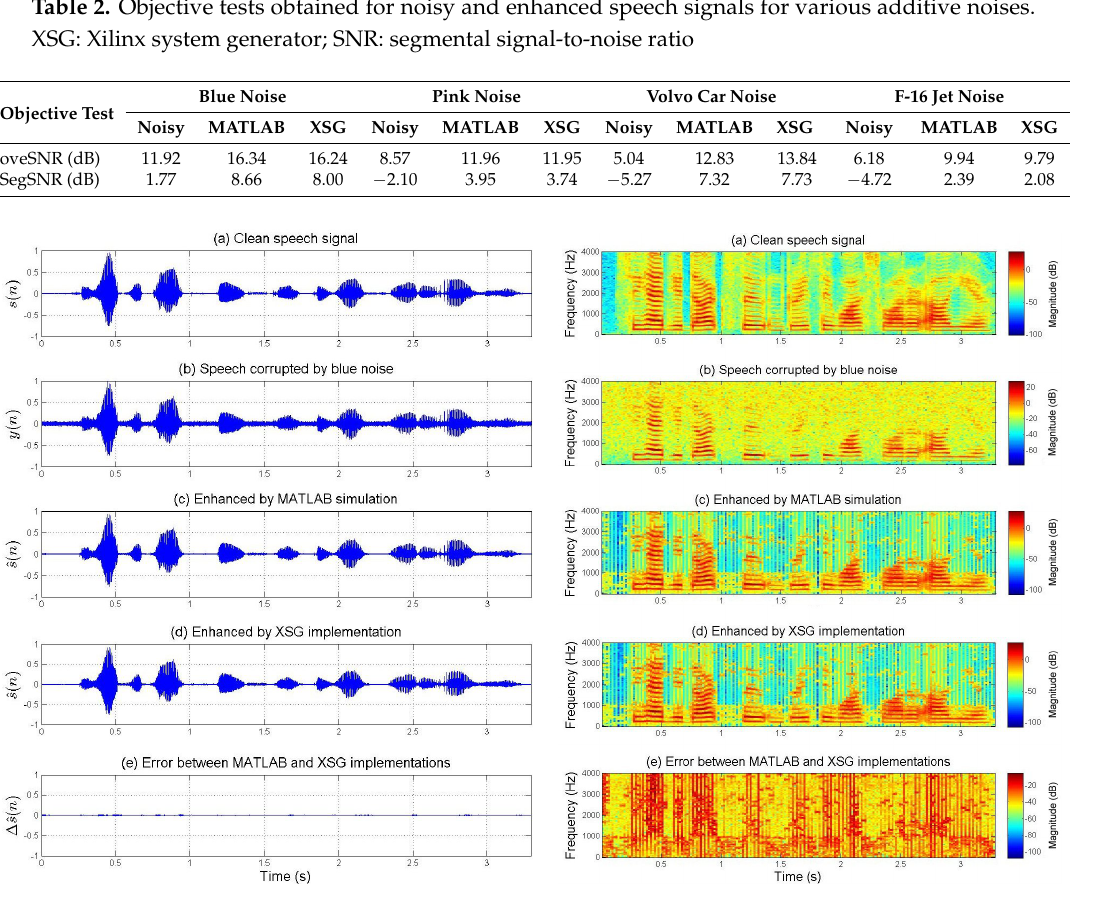
Figure 4. Time waveforms ( left ) and spectrograms ( right ) of clean speech signal ( a ), speech signal corrupted with artificial blue noise ( b ), enhanced speech with floating-point MATLAB simulation ( c ), enhanced with fixed-point XSG implementation ( d ), and error (difference) enhancement between MATLAB and XSG implementations ( e